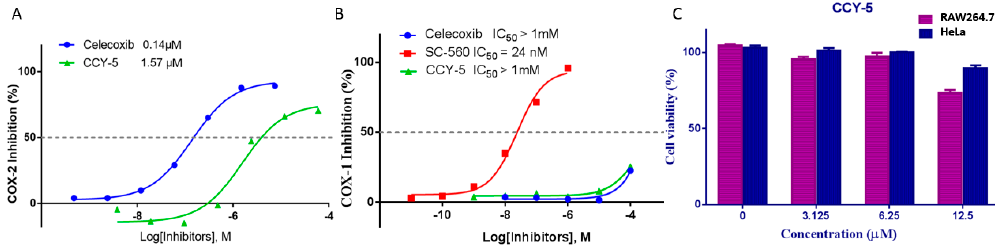
Figure 4. COX-1 / 2 inhibition and cytotoxicity study of celecoxib analogues. ( A ) IC 50 value of celecoxib and CCY-5 with purified COX-2 by inhibition assay in vitro; ( B ) IC 50 value of celecoxib, CCY-5 and SC-560 (COX-1 selective inhibitor) with purified COX-1 by inhibition assay in vitro; ( C ) cell viability values (%) estimated by MTT assays using HeLa cells and RAW264.7 cells, cultured in the presence of 3.125 − 12.5 μ M of CCY-5 for 24 h at 37 °C (* p < 0.05).